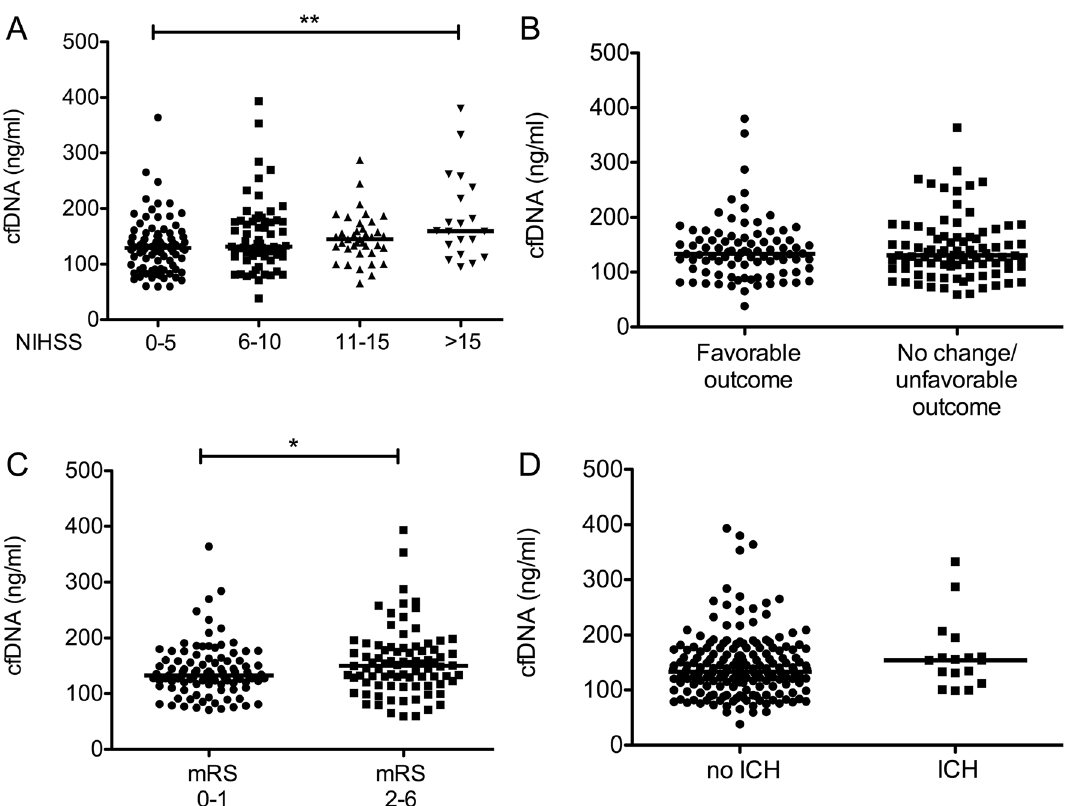
Figure 1. Association between cell free DNA (cfDNA) levels on admission and the severity and outcomes of stroke. Association between cfDNA levels on admission and stroke severity ( A ), short term outcome of stroke ( B ), long-term outcome of stroke ( C ), and therapy-associated intracerebral hemorrhage ( D ). cfDNA, cell free DNA; ICH, intracerebral hemorrhage; NIHSS, National Institutes of Health Stroke Scale, mRS, modified Rankin Scale, **p < 0.01, *p < 0.05 [( A ) Kruskal–Wallis with Dunn-Bonferroni post hoc test, ( B – D ) Mann–Whitney U